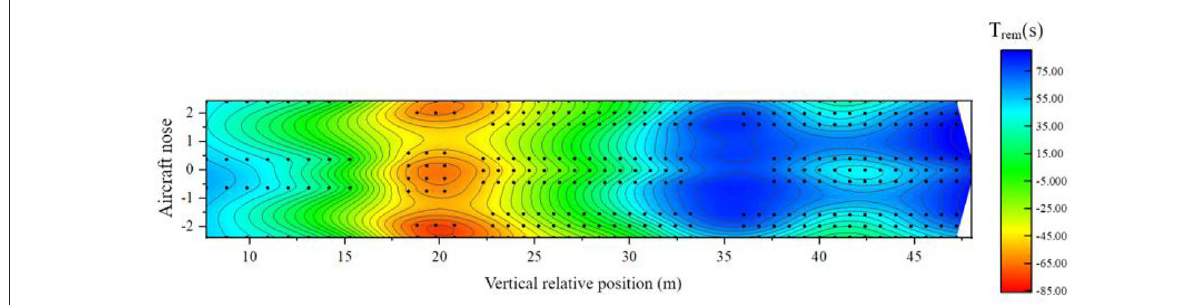
FIGURE19 Distribution of remaining evacuation time when the cabin is horizontal.